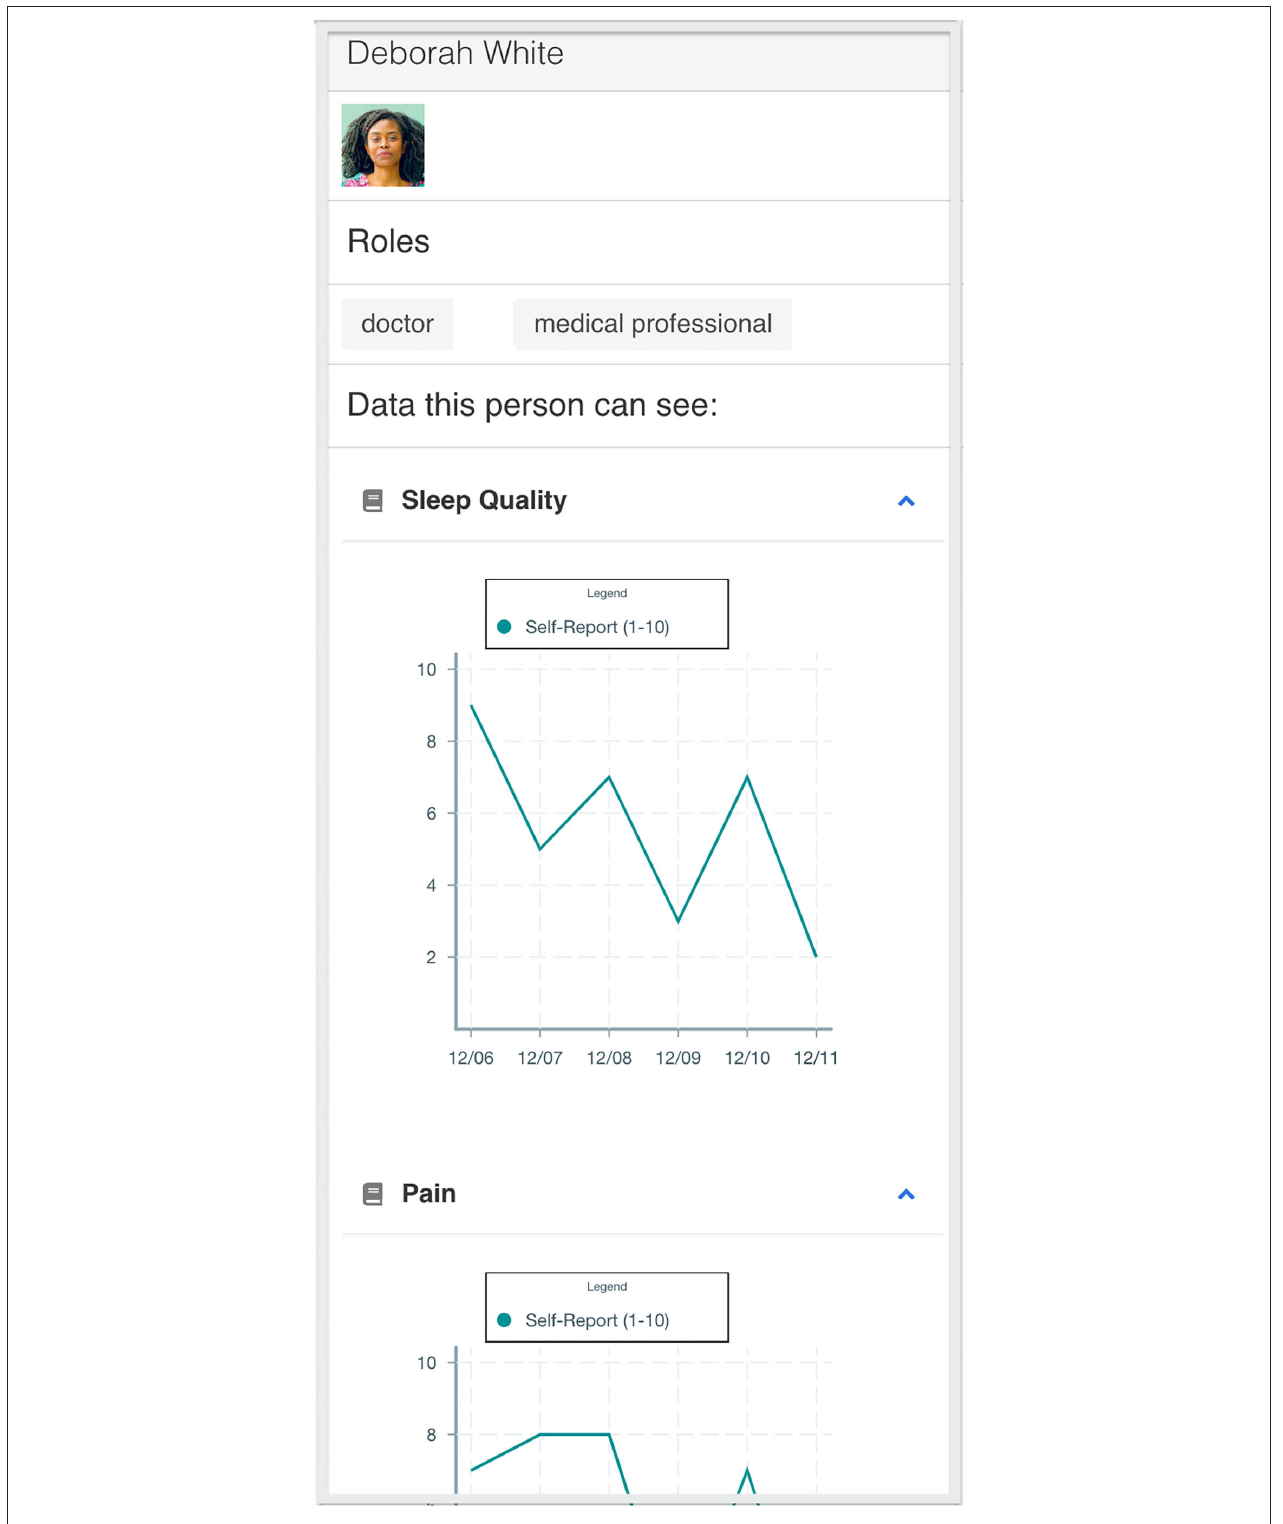
FIGURE 6 | Data Preview: showing data access (Sleep Quality and Pain) for Deborah White. Users can use the data preview to see the effect of the sharing settings (The profile photo used in this screenshot is by Leon Ell’ on Unsplash).